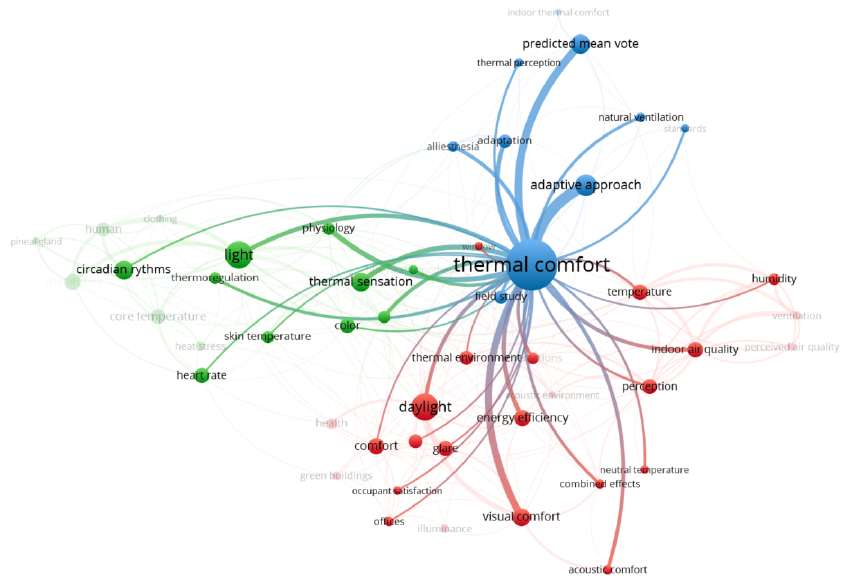
Figure 2. Keywords co-occurrence clustering with VOSviewer.